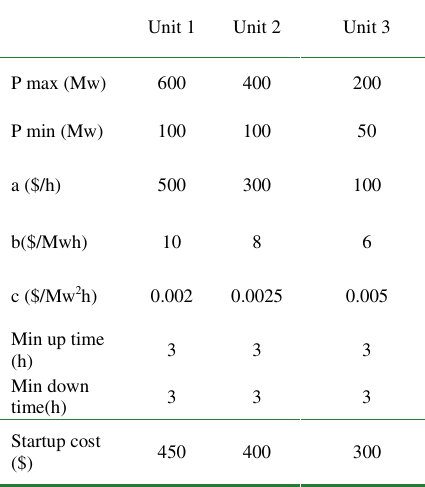
Table A3 Forecasted Demand, Reserve and Spot Prices for Ten-Unit